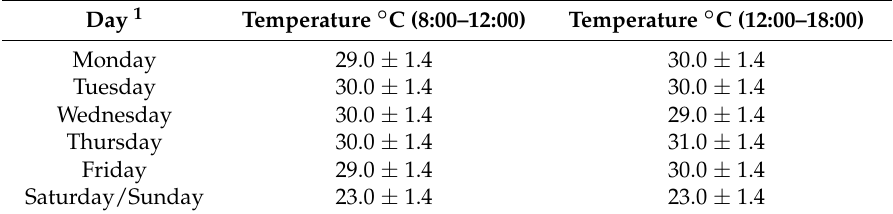
Table 3. Average and standard error of temperature detected on the work surface inside the